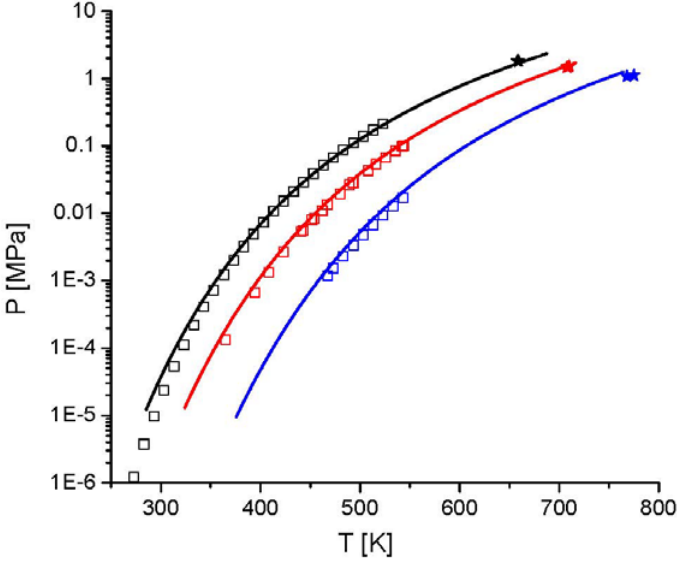
Figure 14. Experimental (black open squares: n -dodecane [131–133]; red open squares: n -pentadecane [132–135]; blue open squares: n -eicosane [132,133]) and calculated vapour = 109.94 K ); pressures of n -alkanes (black line: n -dodecane ( σ = 3.11513 × 10 − 10 m ; ε / k B = 111.143 K ); blue line: n -eicosane red line: n -pentadecane ( σ = 3.08592 × 10 − 10 m ; ε / k B = 112.69 K ). The stars mark the experimental critical ( σ = 3.04986 × 10 − 10 m ; ε / k B points